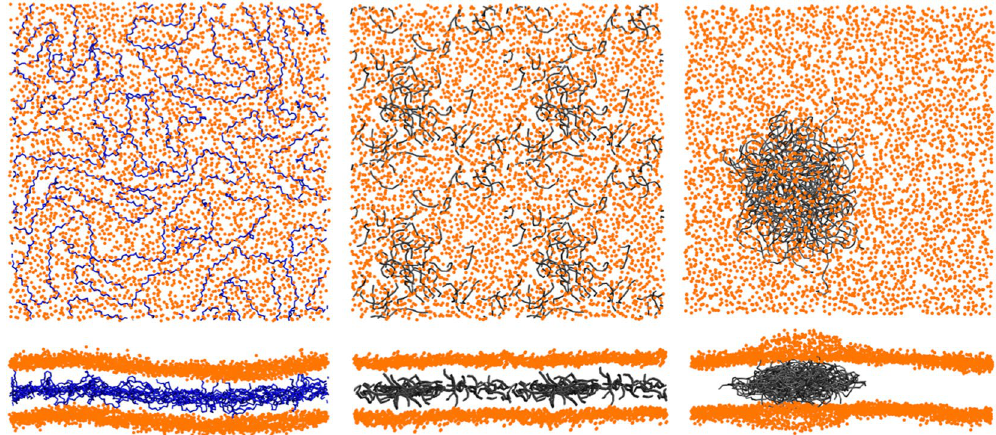
Figure 1. Typical distributions of the polymers inside pure POPC membranes (lipid:polymer mass ratio of 6.6%). Two views of the membrane (only head beads, in orange) are shown for each configuration: from the top and from the side. Left: PP107 chains (in blue). Middle: PE10 chains (in gray). Here the membrane contained only 512 lipids, and has been multiplied by 4 to have the same scale as other pictures. Right: PE80 chains (in gray).